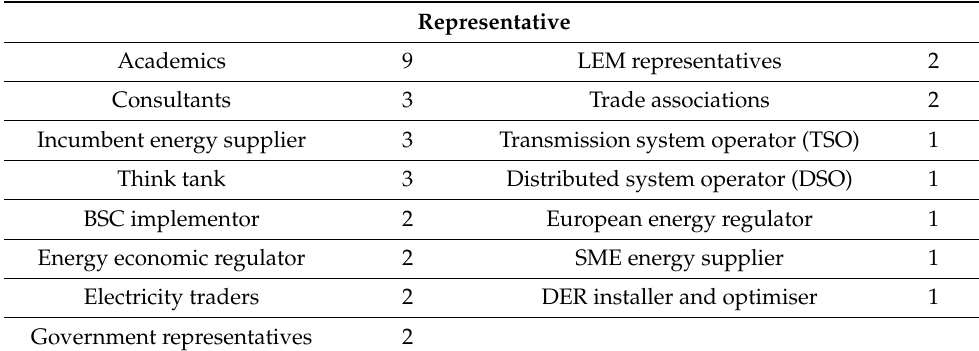
Table 2. Interviewee shareholder